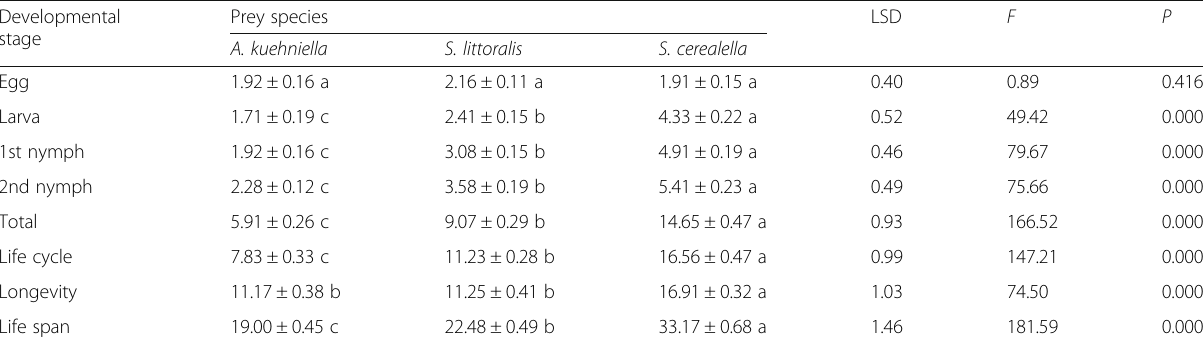
Table 1 Duration (in days) of male developmental stages of Neosiulus cucumeris fed on eggs of Anagasta kuehniella , Spodoptera littoralis , and Sitotroga cerealella and incubated at 27 °C and 70% RH Developmental